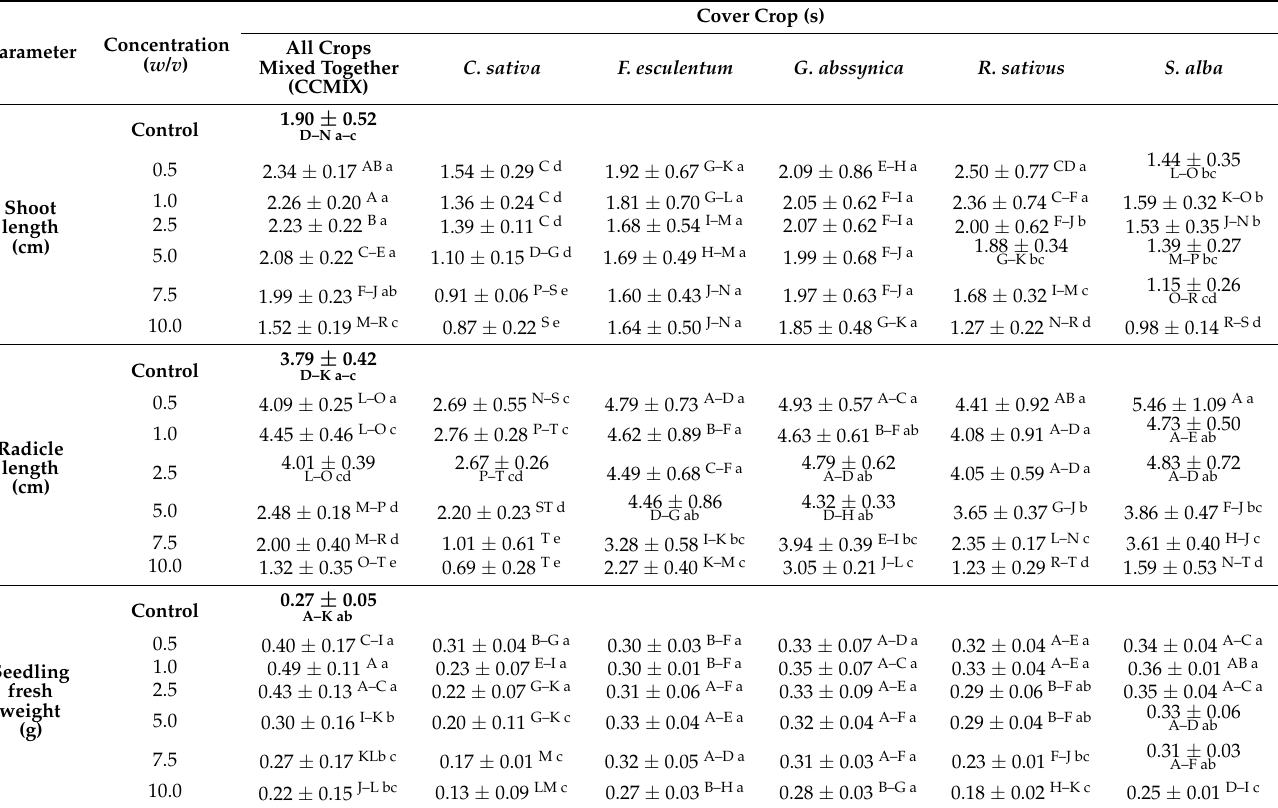
Table 2. Allelopathic effect of different concentrations of aqueous extracts of cover crops on A. artemisiifolia shoot length, radicle length and seedling fresh